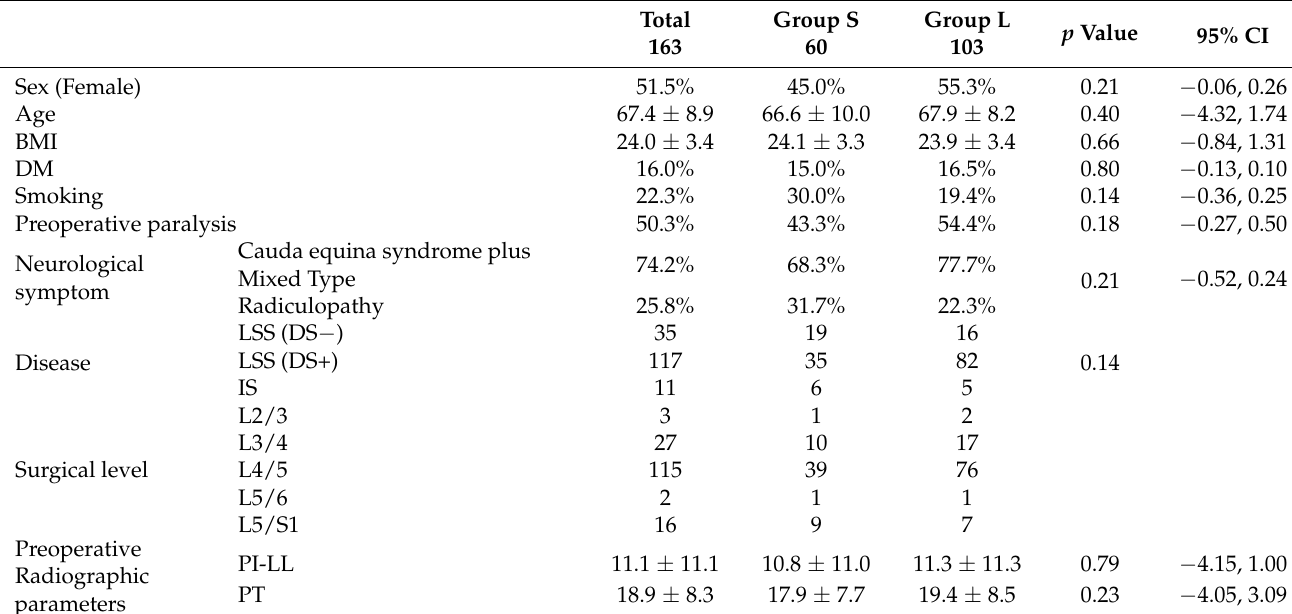
Table 1. Patient